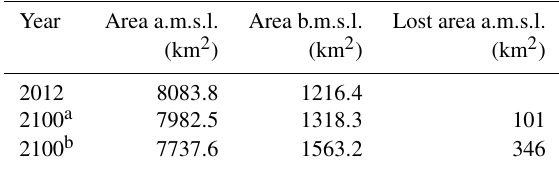
Table 5. Areas expected to be above (a.m.s.l.) and below mean sea